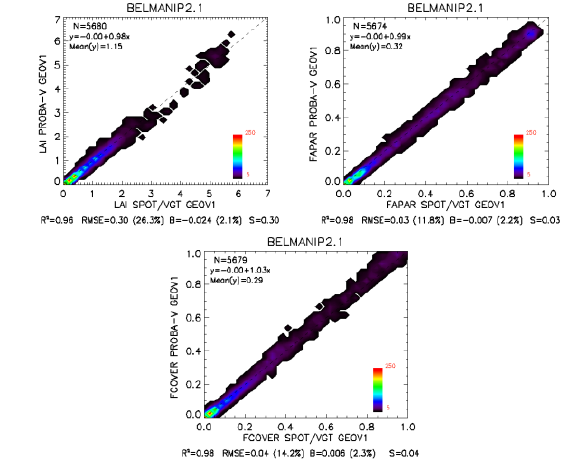
Figure 10: LAI, FAPAR and FCover PROBA-V GEOV1 versus SPOT/VGT GEOV1 products scatter-plots over all BELMANIP-2.1 sites for the November 2103 - May 2014 period. The terms B and S represent the mean and the standard deviation of the difference.